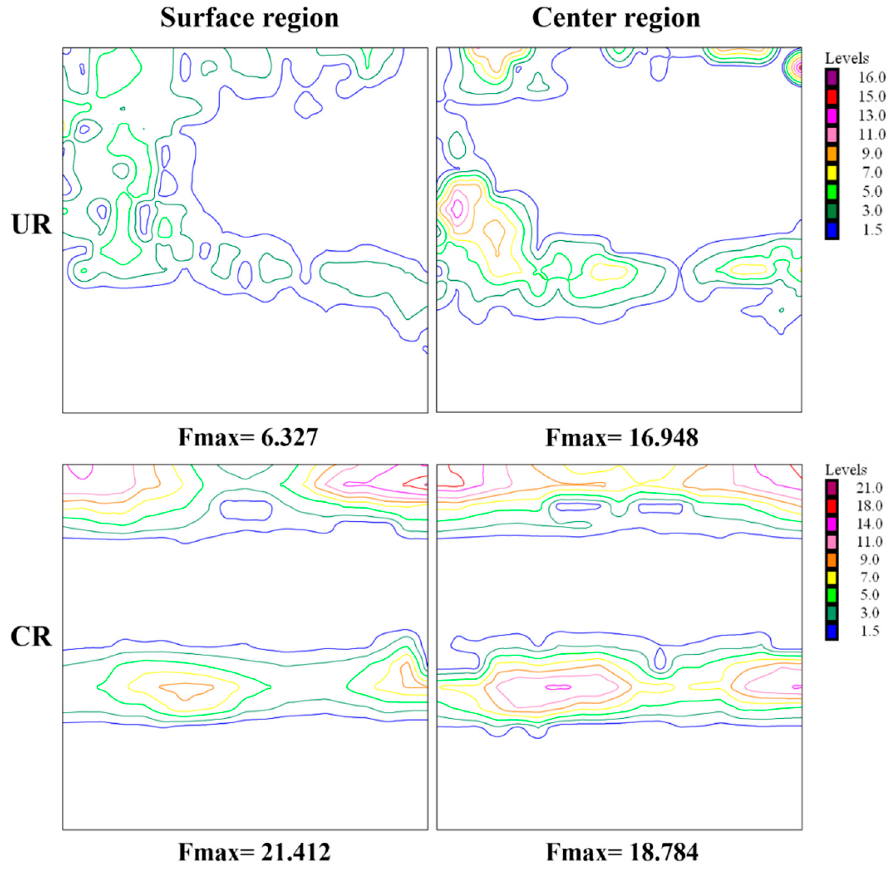
Figure 1. Orientation distribution function (ODF) sections ( ϕ 2 = 45 ◦ ) at the surface and center region for unidirectional rolled-Ta (UR-Ta) and clock rolled-Ta (CR-Ta).